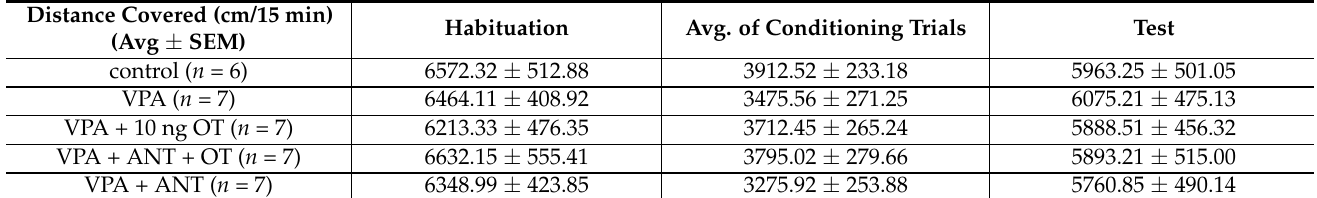
Table 1. Distance moved during the CPP trial ( ± S.E.M.) Control: neurotypical/sham male Wistar rats receiving intraamygdaloid PBS ( n = 6); VPA: intrauterine VPA-treated rats showing autistic-like behavior ( n = 7); VPA + 10 ng OT: animals showing autistic-like behavior, microinjected with 10 ng OT ( n = 7); VPA + ANT + OT: animals with autistic-like behavior, microinjected with 20 ng OT receptor